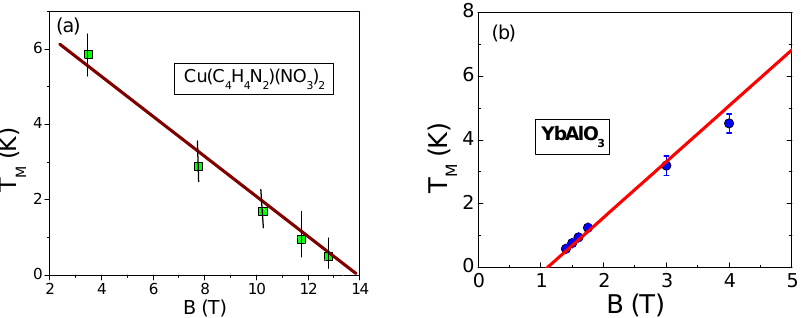
T M − T M dependence for − B s B given by | − |